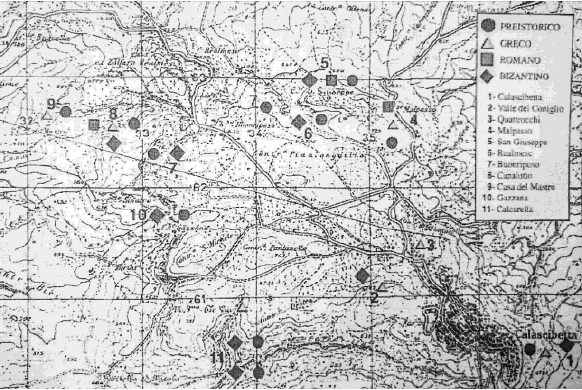
Figure 1. Archaeological sites in the territory of